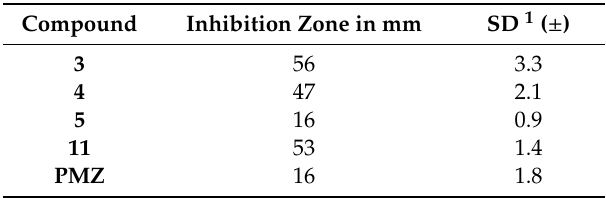
Table 4. The quorum sensing inhibitory effect of the active compounds and the positive control promethazine (PMZ).